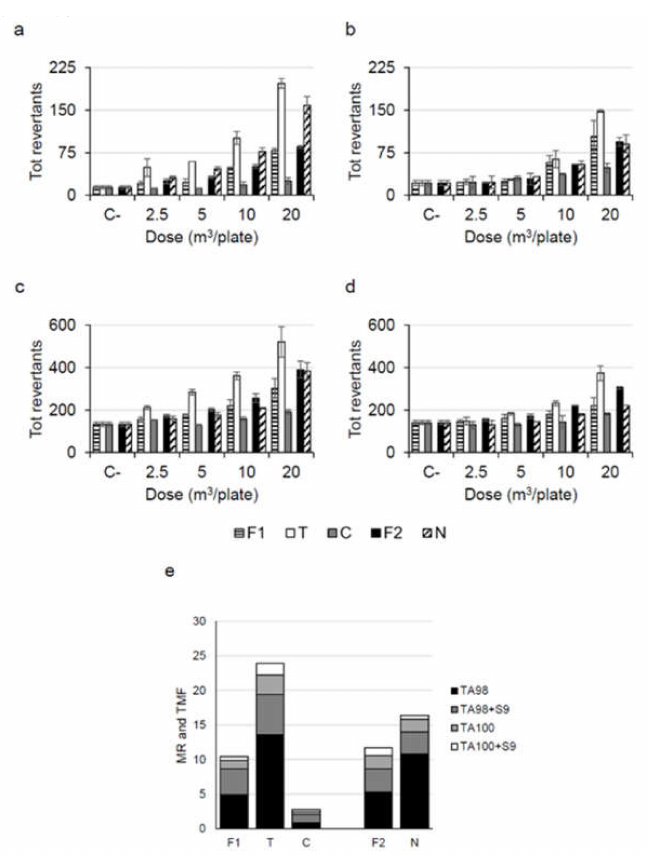
Figure 3. Mutagenicity detected in PM extracts using different Salmonella typhimurium strains with and without metabolic activation ( ± S9). Data are expressed as: total revertants and mutagenic- ity ratio in 20 m 3 of air (MR). TMF = Total Mutagenicity Factor ( ∑ MR); F1 = PM 10 extract from Chiomonte—site F (rural site, fire site); T = PM 10 extract from Torino—site T (urban site); C = PM 10 extract from Ceresole Reale—site C (rural site); F2 = PM 2.5 extract from Chiomonte—site F (rural site, fire site); N = PM 2.5 extract from Novara—site N (urban site). ( a ): total revertants—strain TA98, ( b ): total revertants—strain TA98 with metabolic activation (+S9), ( c ): total revertants—strain TA100, ( d ): total revertants—strain TA100 with metabolic activation (+S9), ( e ): MR and TMF—all strains with and without metabolic activation ( ±